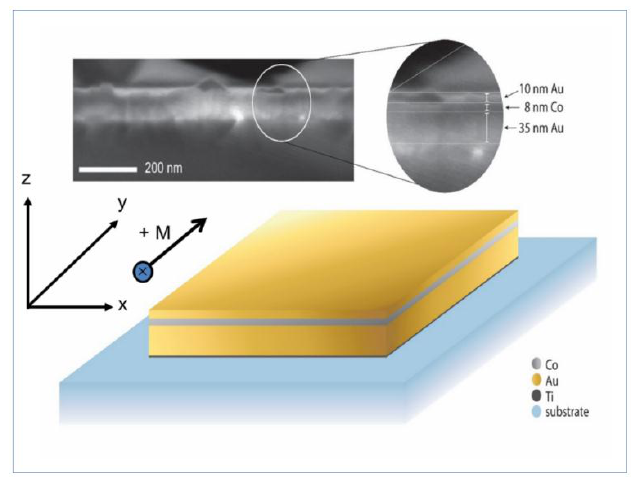
Figure 5. Schematic of a fabricated sensor configuration (bottom). Shown on the top left is the side view of the fabricated sensor studied using SEM (FEI Apreo SEM, ThermoFisher Scientific, Hillsboro, OR, USA). Enlarged view is shown on the top right. The orientation of magnetic spin is shown by a large thick arrow that is parallel to the Co/Au interface. A positive direction of applied H field is assumed to be along the direction shown by the long thick arrow (i.e., +y-axis). Table 2. Optical parameters at λ = 785 nm used for modeling. ε moCo is the complex magneto-optic constant of Co, also known as off-diagonal tensor component ( ε moCo = − 0.85 + j0.0006 at λ = 785 nm), obtained from a past paper